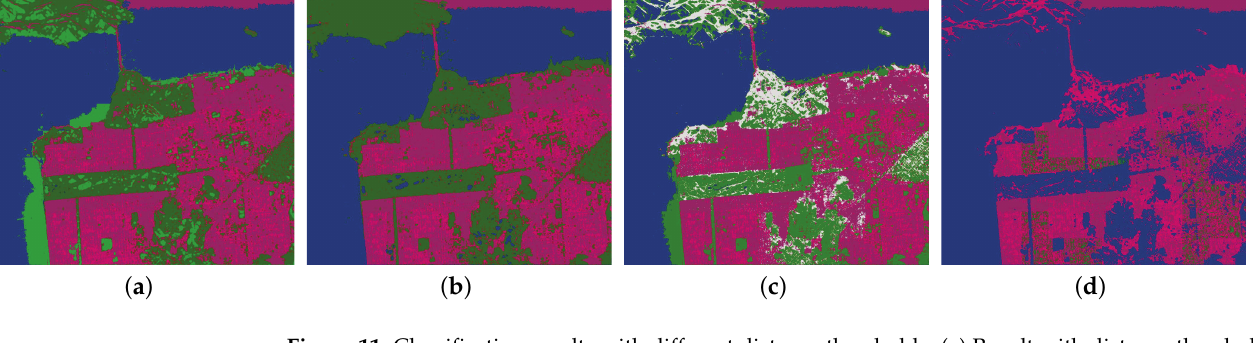
Figure 11. Classification results with different distance thresholds. ( a ) Result with distance threshold 0.5%. ( b ) Result with distance threshold 1.0%. ( c ) Result with distance threshold 1.5%. ( d ) Result with distance threshold